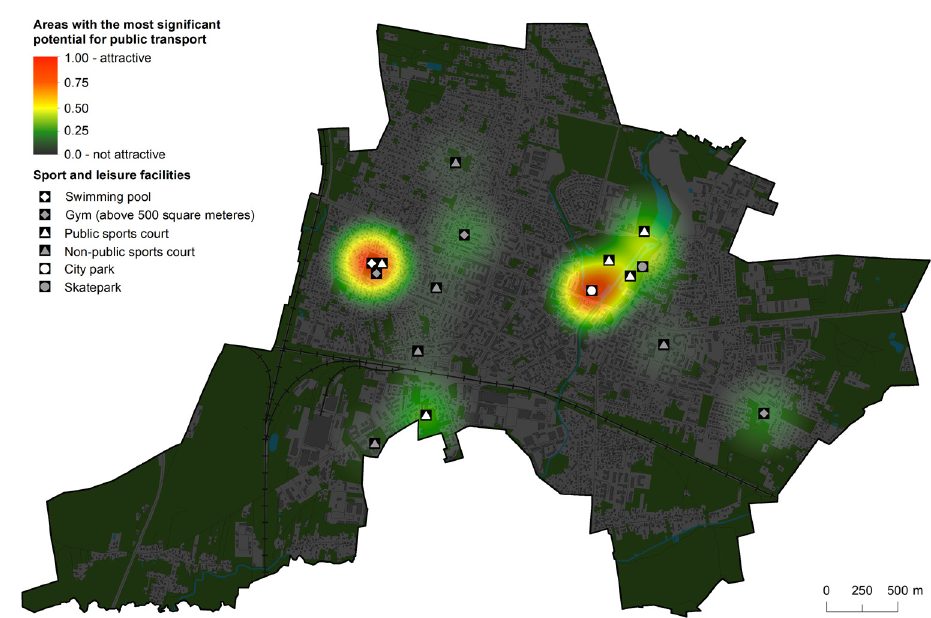
Fig. 5. With the most significant potential for public transport in means of sport or leisure